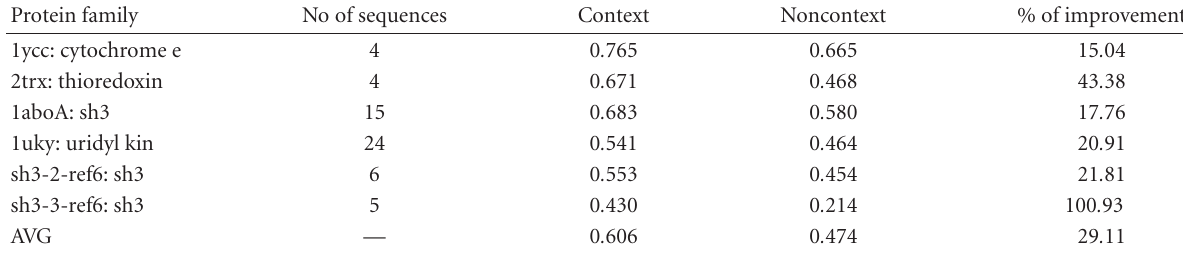
Table 6. Families for which the contextual model gives much better